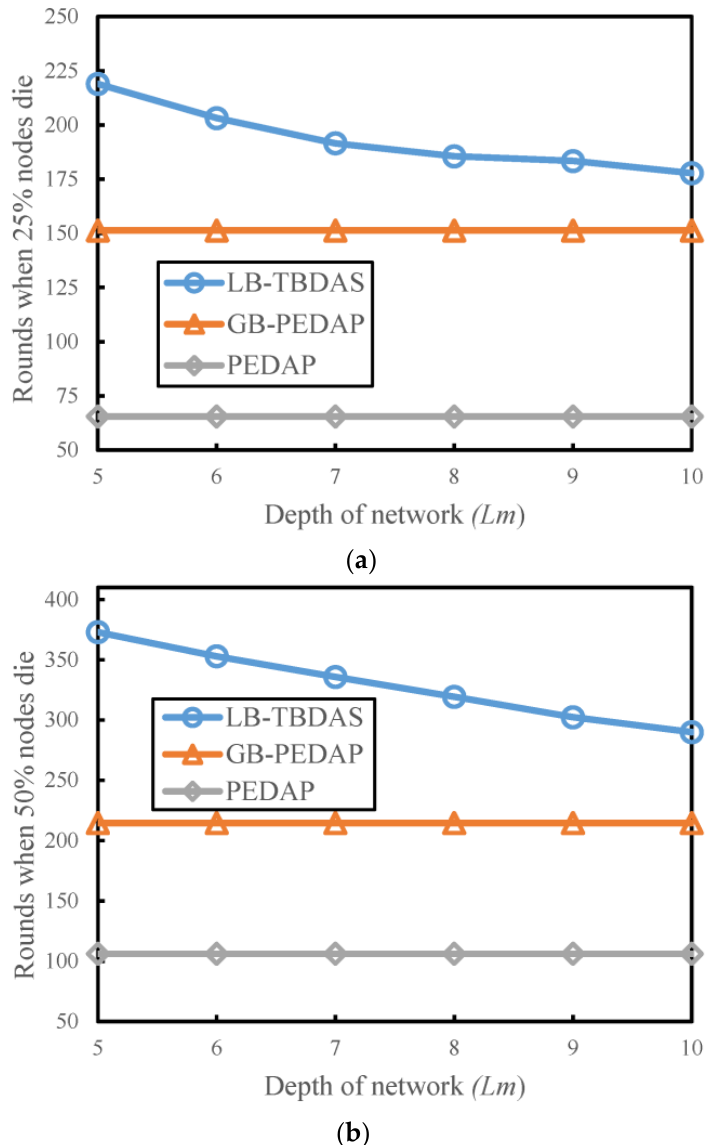
Figure 7. Number of rounds versus depth of network: ( a ) 25% of nodes die; ( b ) 50% of nodes die.